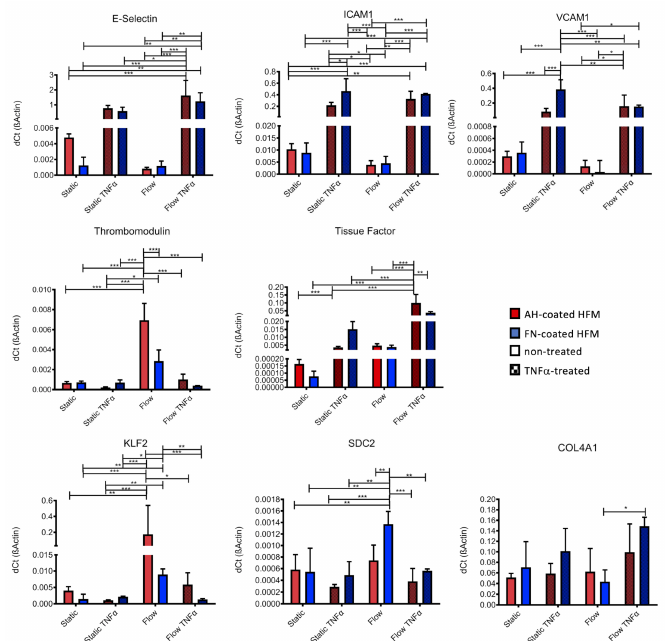
Figure 8. Gene expression analysis for EC activation state detection and the regulation of extracellular matrix components under flow conditions by realtime qRT-PCR. Expression levels were compared between ECs on both coated HFM under static conditions and under flow exposure, and with or without TNF α treatment (* p < 0.05, ** p < 0.01, *** p < 0.001). KLF2, a known indicator for shear stress response, was significantly upregulated on both coating types only under flow conditions. After additional TNF α activation under flow conditions, KLF2 expression levels dropped back to levels that were detected under static